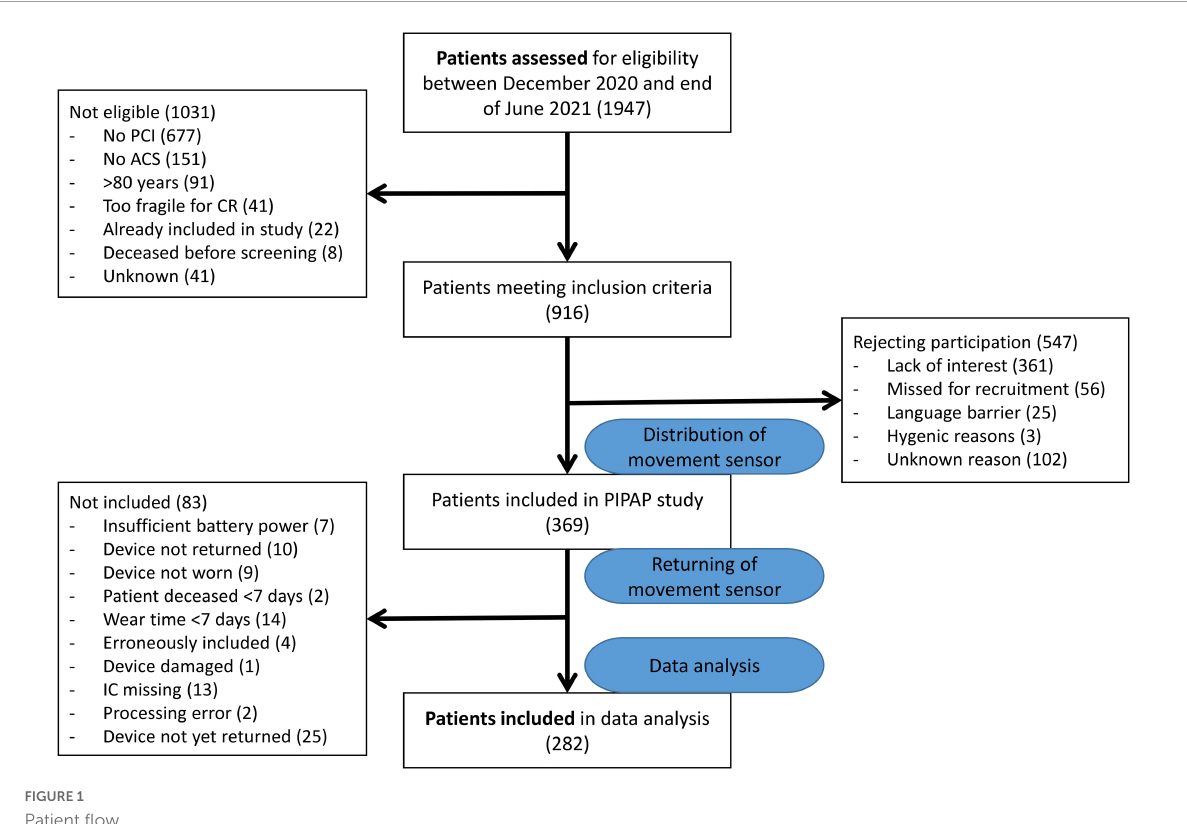
FIGURE1 Patient